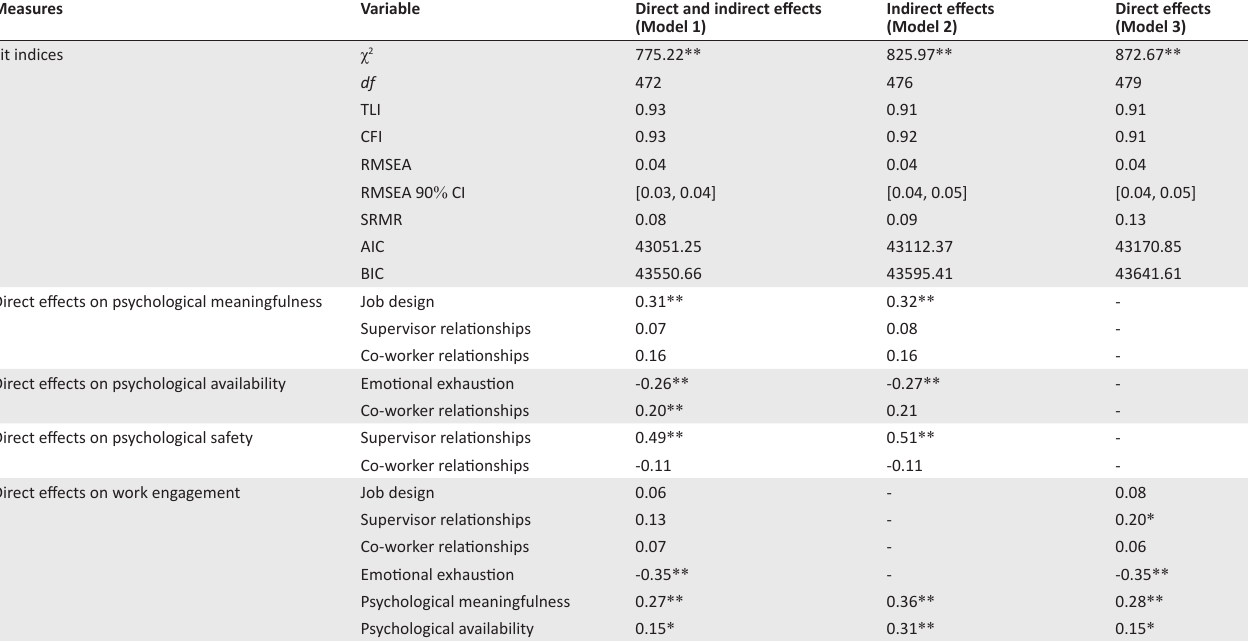
TABLE 3: Fit indices and standardised path coefficients of the structural